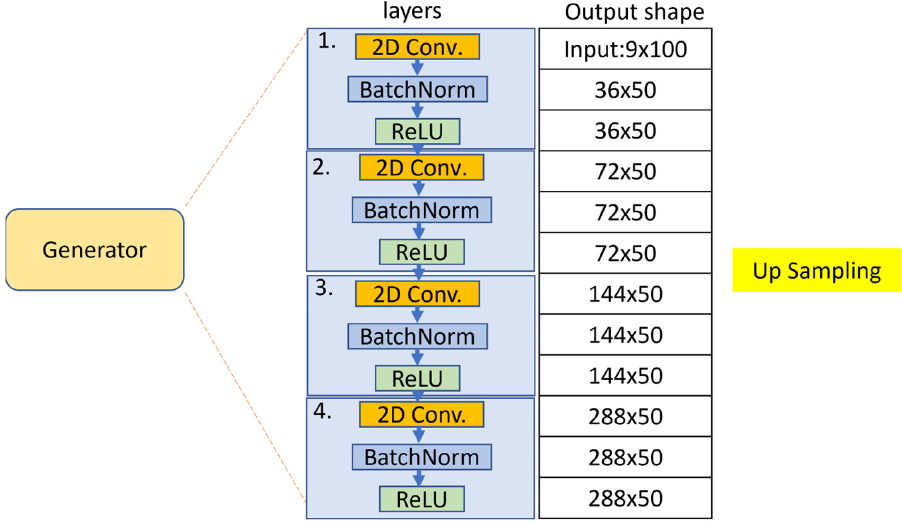
Figure 6. The block diagram of the generator.